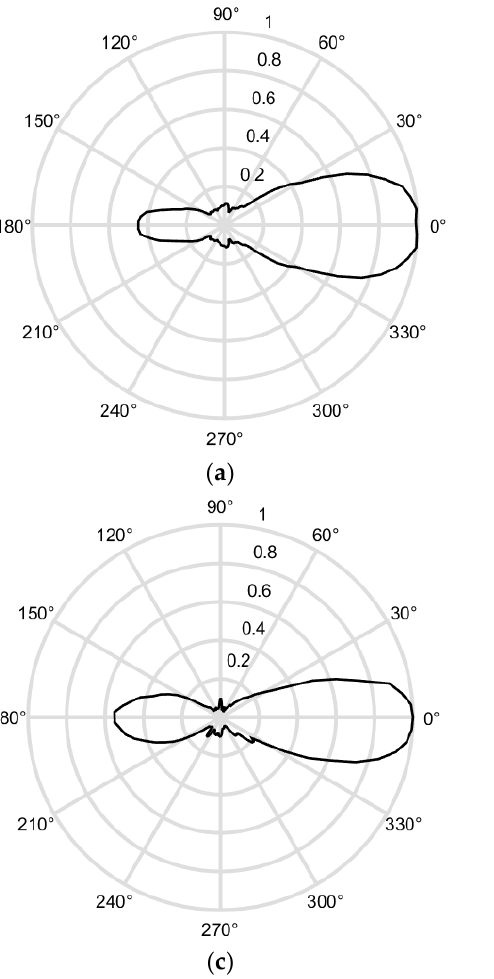
Figure 21. Results after 3D filtering: ( a ) simulated directivity pattern; ( b ) simulated velocity of the A 0 mode in the film; ( c ) measured directivity pattern; and ( d ) measured velocity of the A 0 mode in the film.